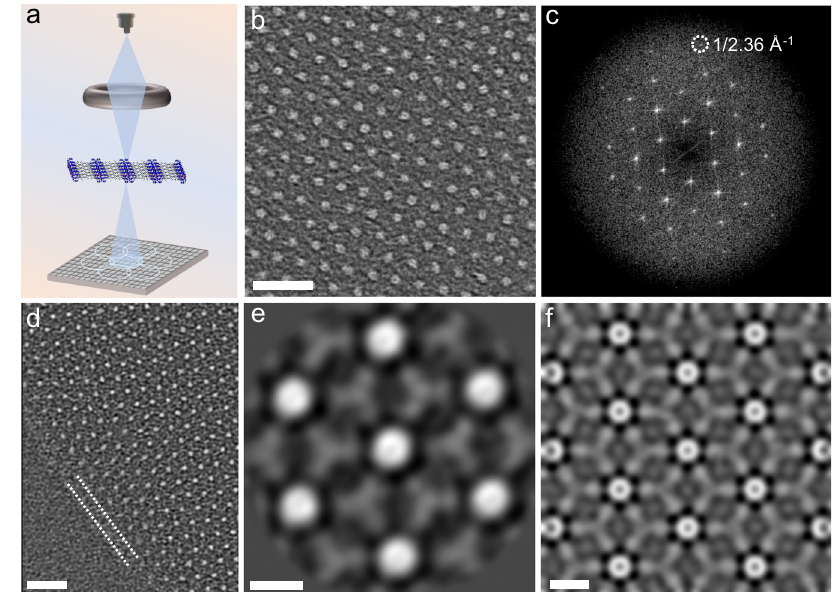
Fig. 4 | Electron ptychographic reconstruction of Hf-MOLs using a high frame rate direct electron detector. a Experimental setup for electron ptychography. b PtychographicreconstructionofMOLsfrom4D-STEMdata. c IntensityofFourier transformofthereconstructedphaseimageofHf-MOLs,inwhichthedashedwhite circle represents information transfer to 1/2.36Å − 1 . d Ptychographic reconstructed